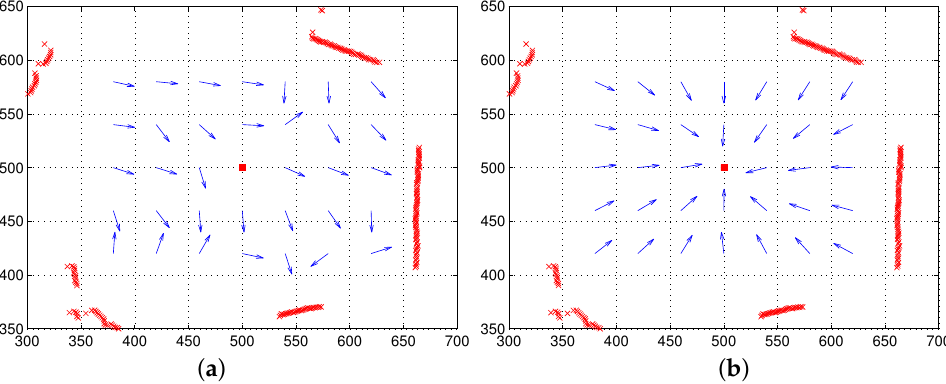
Figure 8. Homing performance only with color intensity or only with range data (reference compass available): ( a ) only with vision, but the unit distance ( r i = 1) (all landmarks have equal distances); ( b ) with only range data, but the unit feature ( C i = 1) (all landmarks have the same visual feature or same color intensity) (the red box at (500,500) indicates home, and arrows show the homing direction at each point).